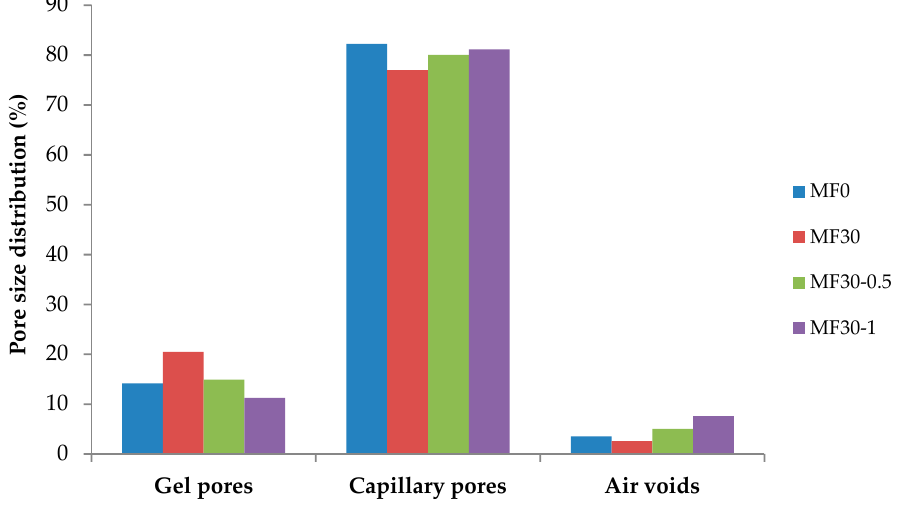
Figure 14. Pore size distribution of MF0, MF30, MF30-0.5, and MF30-1.